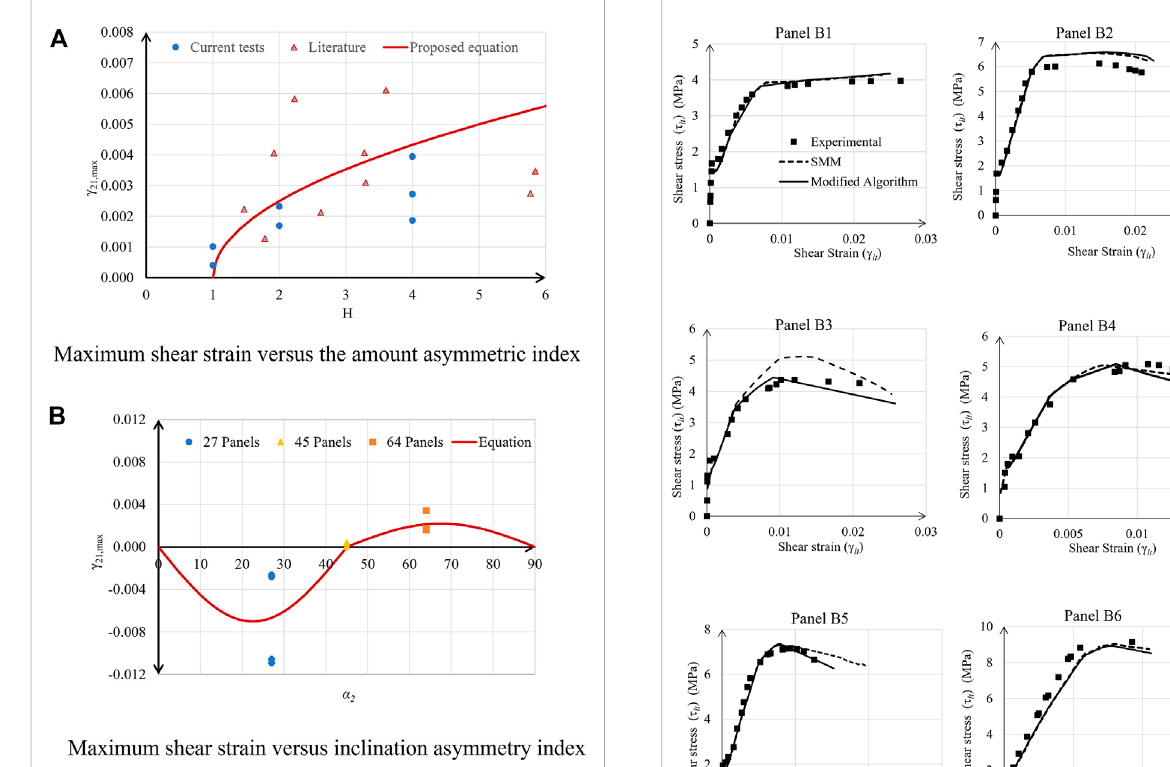
FIGURE 13 Maximum shear strain versus asymmetry. (A) Maximum shear strain versus the amount asymmetric index. (B) Maximum shear strain versus inclination asymmetry index.